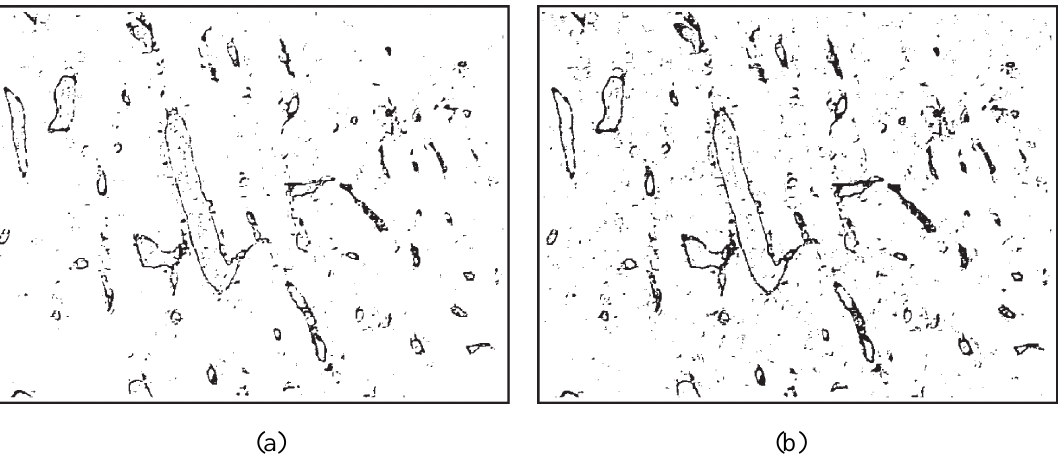
Fig. 4. Example of interactive manual segmentations accepted by the same operator. (a) First segmentation; area: 3.83%. (b) Sec- ond segmentation; area: 5.78%. The difference in area between these two images is about